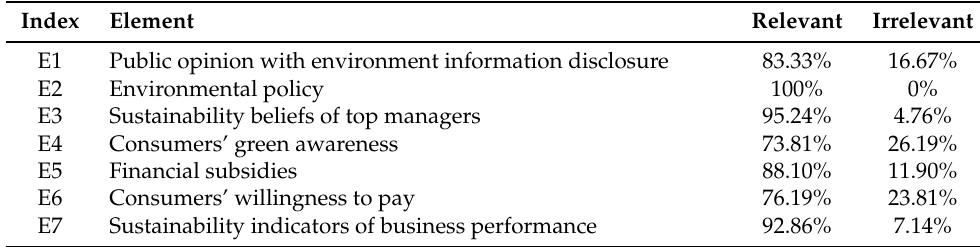
Table 3. Summary of elements to be identified as enablers.